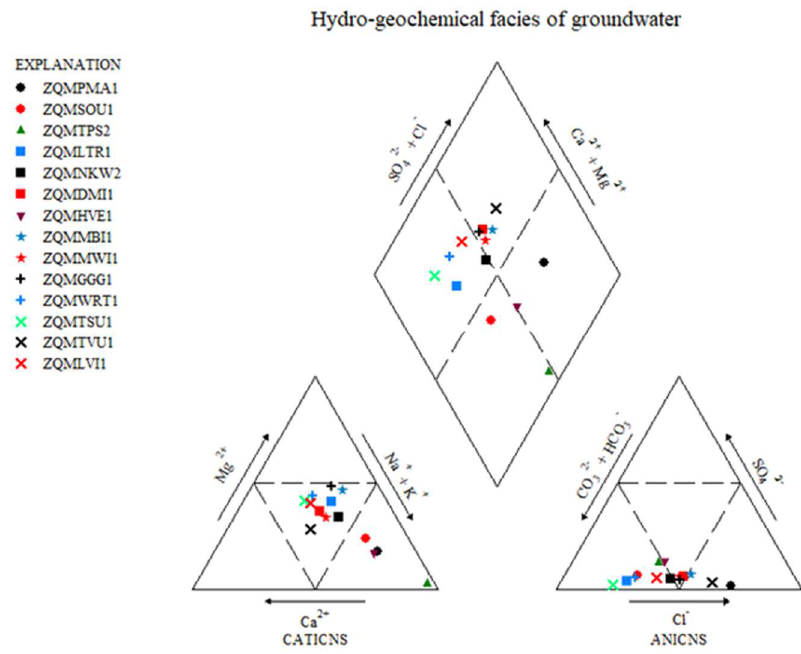
Figure 3. Piper diagram indicating the water types in the Soutpansberg region.